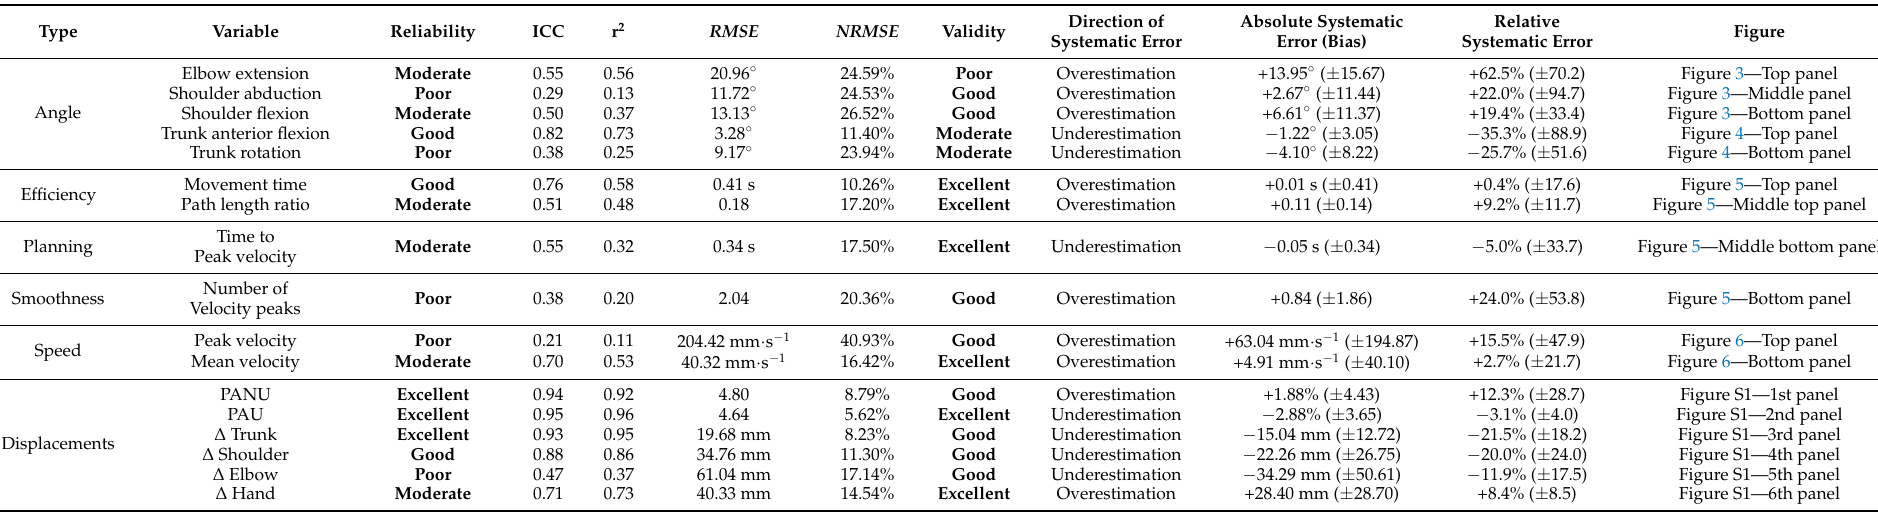
Figure Figure 3—Top panel Figure 5—Top panel Figure 5—Middle bottom panel Figure 5—Bottom panel Figure 6—Top panel Figure S1—1st panel